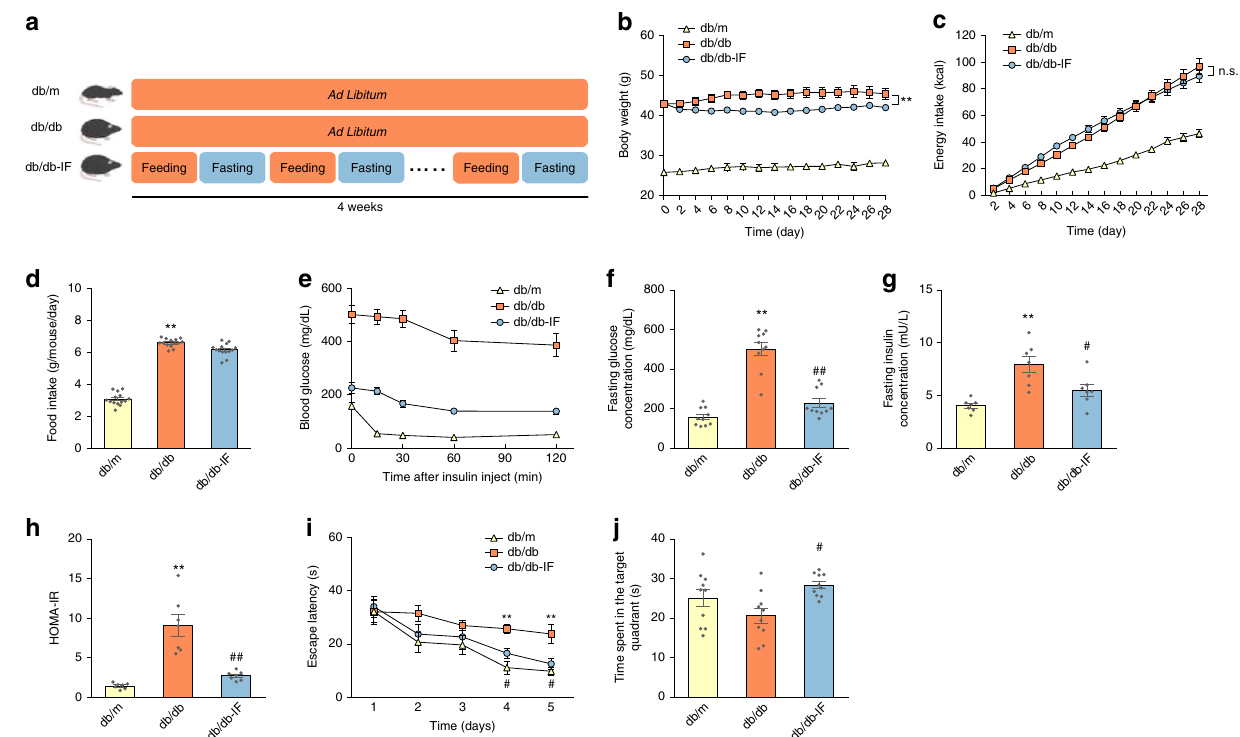
Fig. 1 Intermittent fasting alleviated insulin resistance and cognitive impairment in db/db mice. a Timeline depicting the diet of IF or ad libitum in each group; b bodyweight ( n = 10 mice per group); c energy intake; d food intake; e insulin-tolerance test; f fasting glucose; g fasting insulin level ( n = 7 mice per group); h HOMA-IR ( n = 7 mice per group). The animals ’ cognitive functions were assessed by the Morris water-maze test as described in “ Methods ” ( n = 10 mice per group); i escape latency (s), and j the time spent in the target quadrant (s) during the probe trial were recorded. Data presented as mean ± SEM. * p < 0.05, ** p < 0.01, compared with db/m group, # p < 0.05, ## p < 0.01 compared with the db/db group. Signi fi cant differences between mean values were determined by one-way ANOVA with Tukey ’ s multiple comparisons test. See also Supplementary Fig. 1. Source data are provided as a Source Data fi